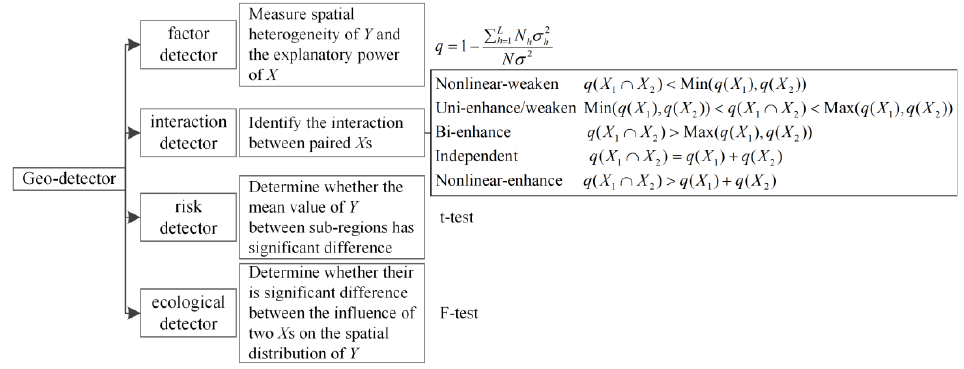
Figure 12. Geo-detector and its composition.